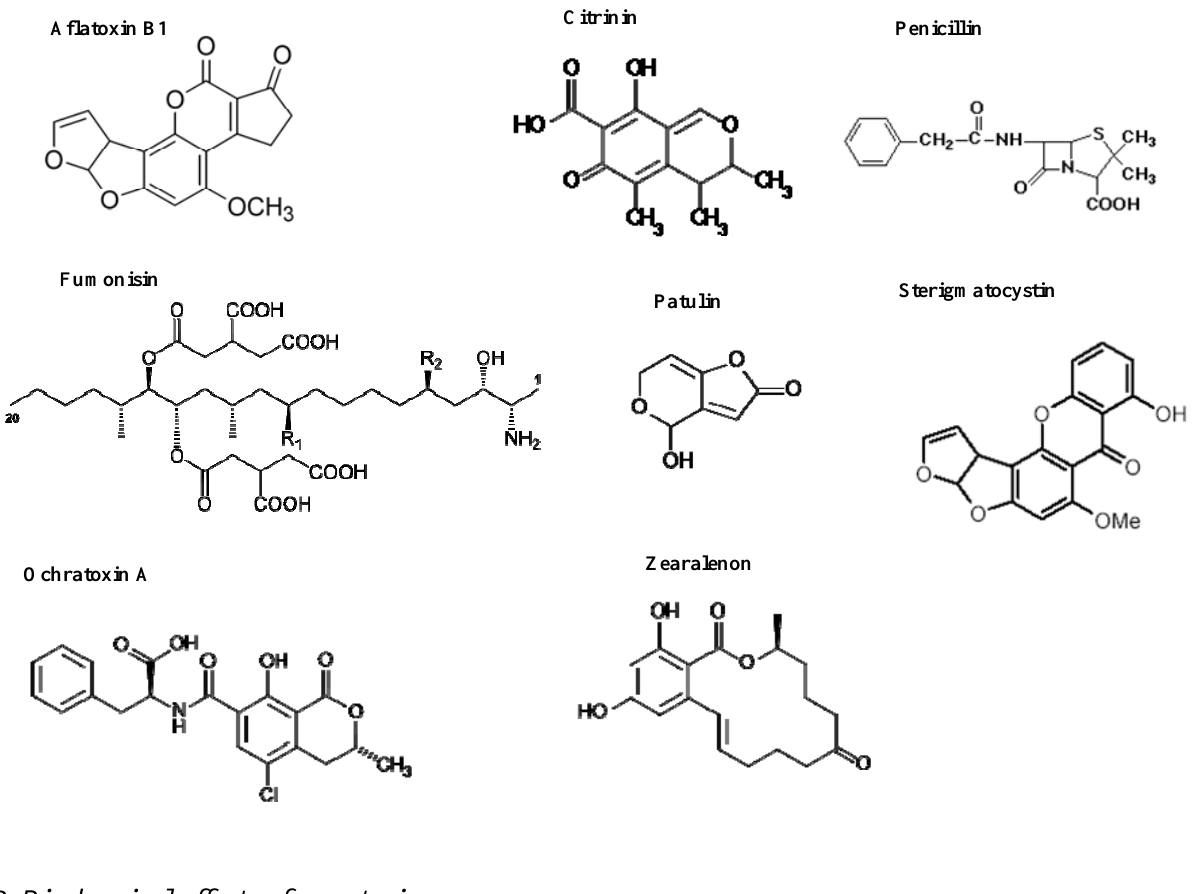
Figure 1. Chemical structures of mycotoxins produced by fungi of genera Aspergillus , Penicillium and Fusarium